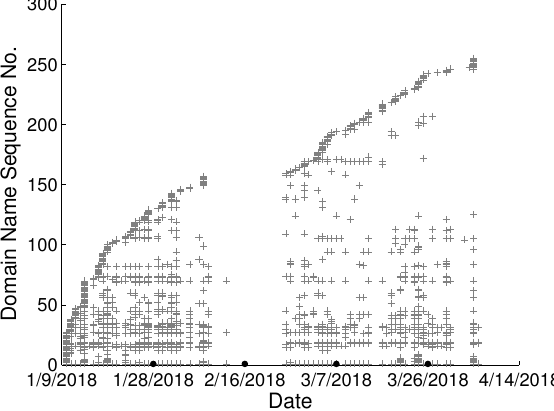
Figure 4. Domain names visited in chronological order from user C in our lab.